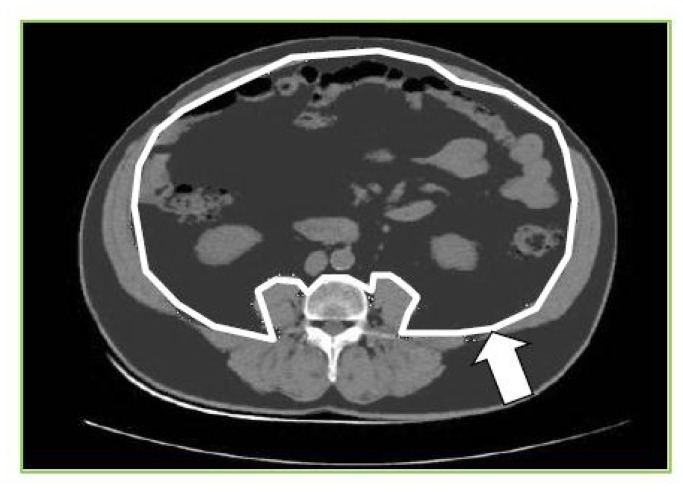
Measurement of VAT and SAT from CT image at L4.Adipose tissue is dark grey, white line shows delineation of visceral compartment, white arrow indicates depth of subcutaneous compartment.